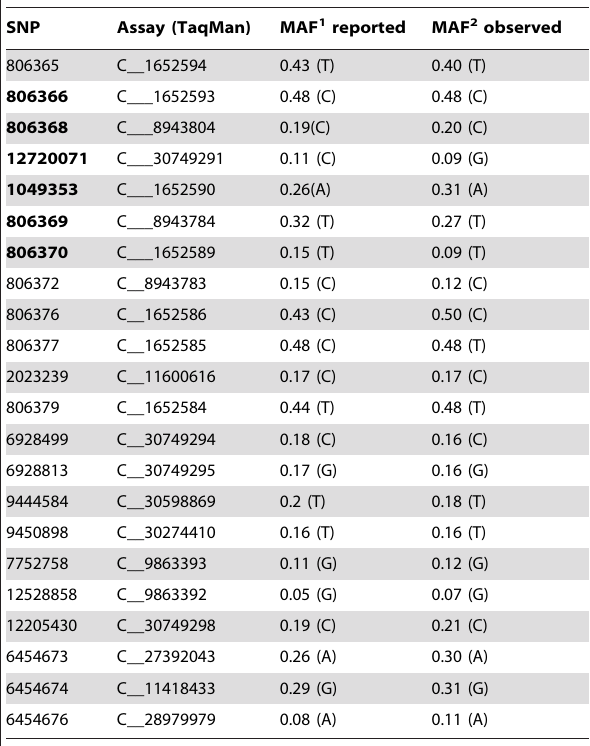
Table 2. Tag SNP minor allele